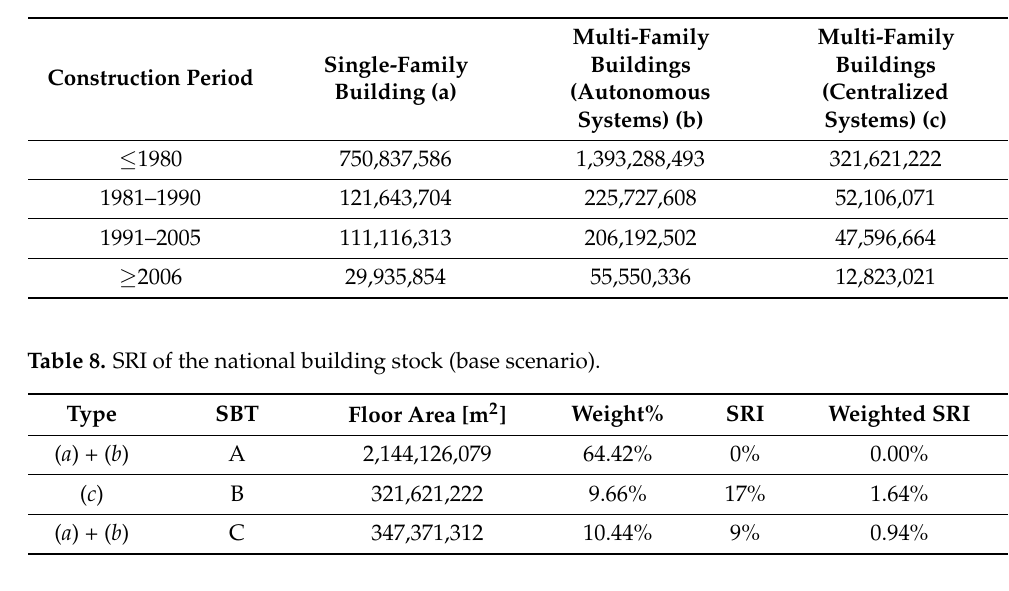
Table 7. Estimated floor area of buildings in the National Building Stock, [m 2 ].